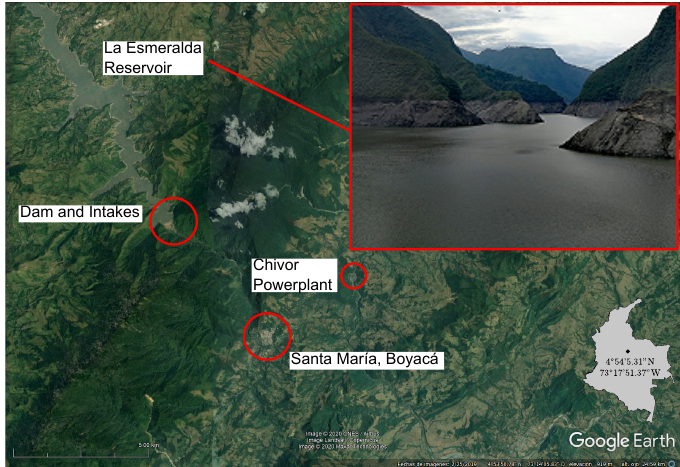
Figure 1. AES Chivor hydropower project. Contains the localization of the reservoir, the dam and intakes, the powerplant, and the town of Santa María, Boyacá. Adapted from Google Earth TM mapping service.